Question: According to this chart, does the measure grow or shrink?
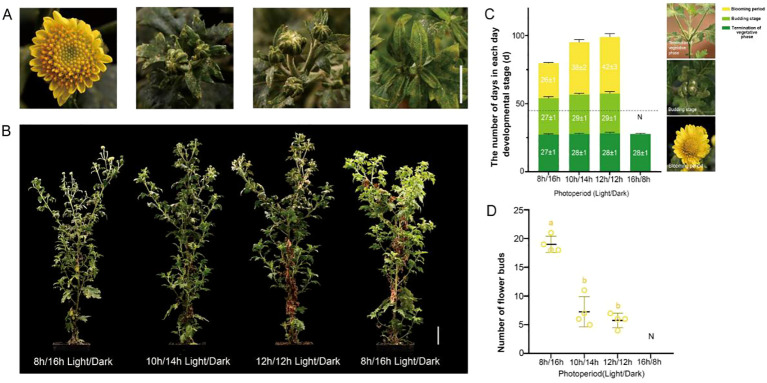
Answer: increasing